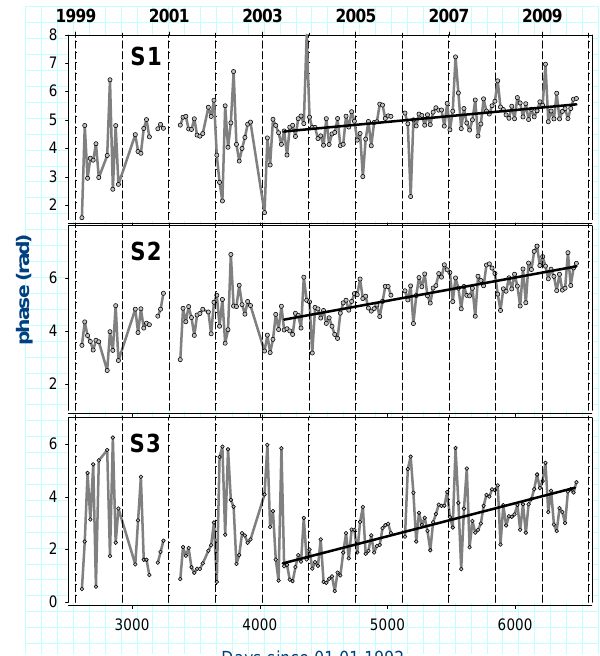
Figure 14: The temporal variation in the radon signal of the phase of the daily periodic components S1, S2 and S3, showing a similar linear multi-year trend, clearly evident in the last seven years.